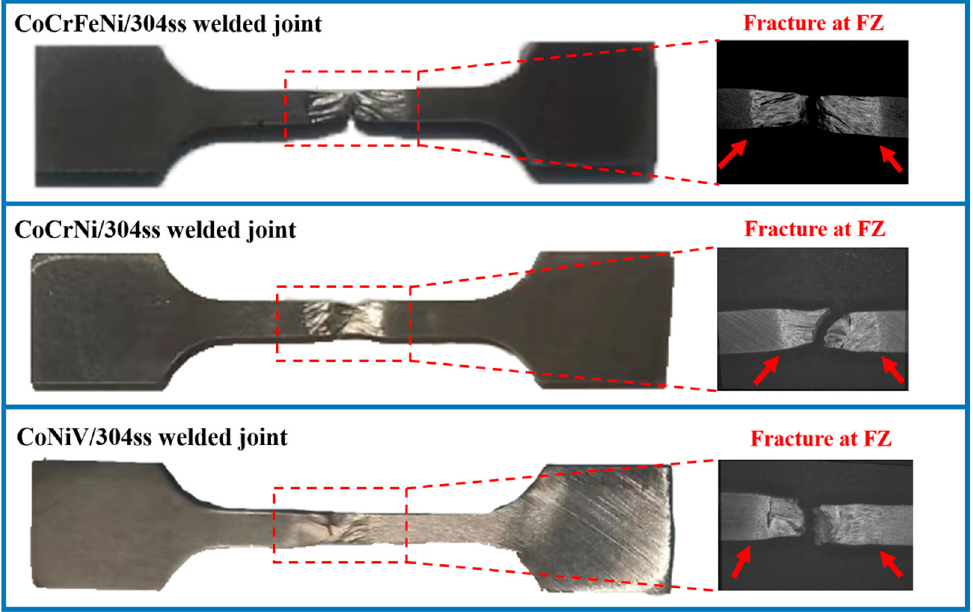
Figure 8. Optical images of the as-welded sample after tensile test. Note that, the arrows indicate the boundaries of severe plastic deformation.